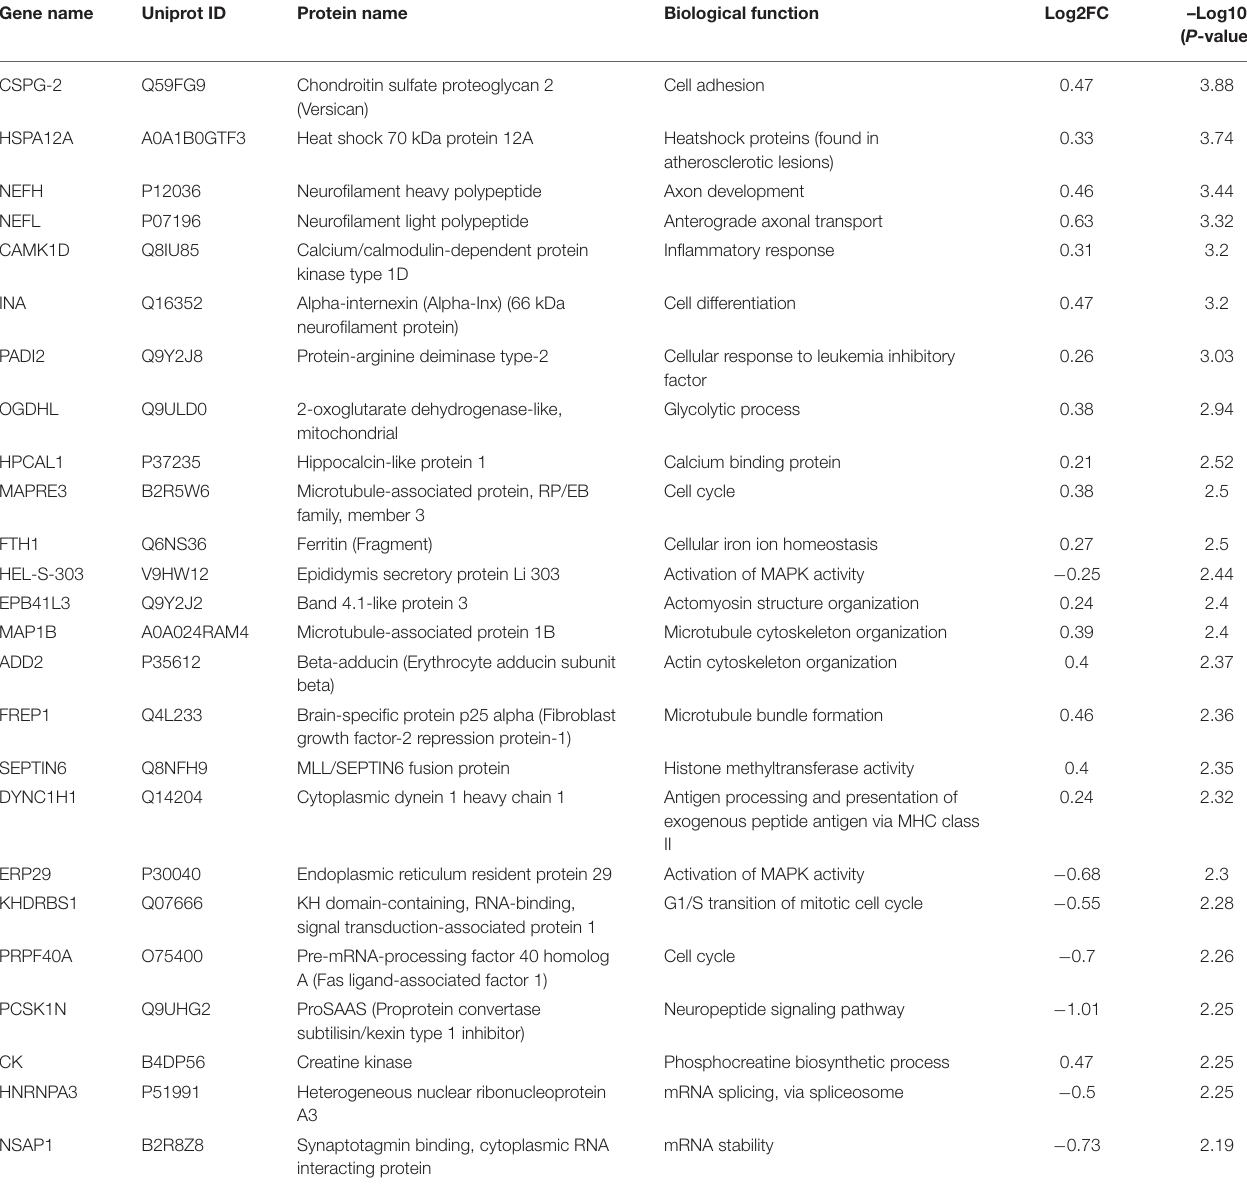
TABLE 2 | List of Top 25 proteins significantly regulated in the inferior frontal gyrus cerebrovasculature of young and aged control